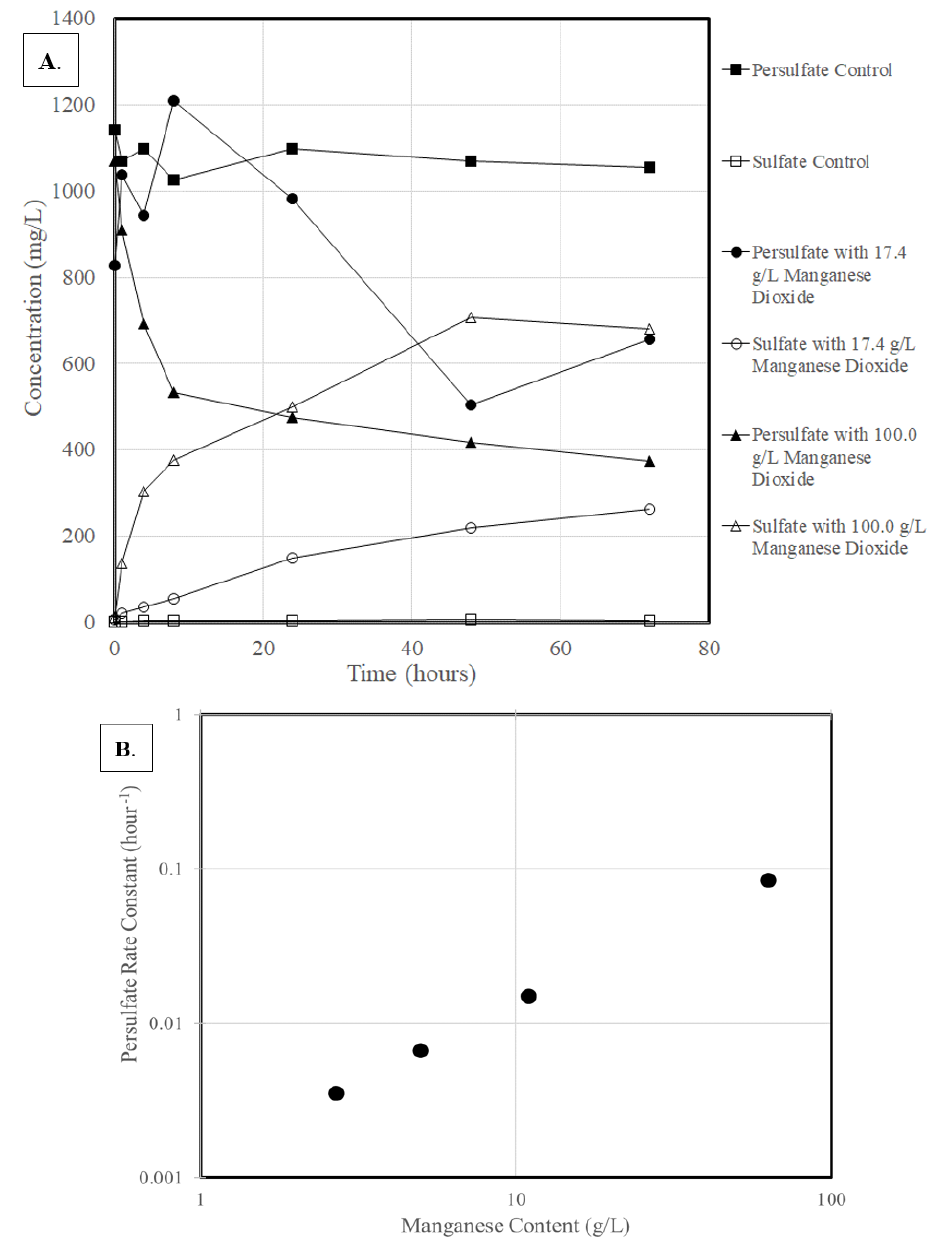
Figure 1. ( A ) Persulfate loss upon activation and sulfate product formation concentration as a function of time with different concentrations of MnO 2 . ( B ) Persulfate activation and decay pseudo 1st order rate coefficient as a function of Mn content.